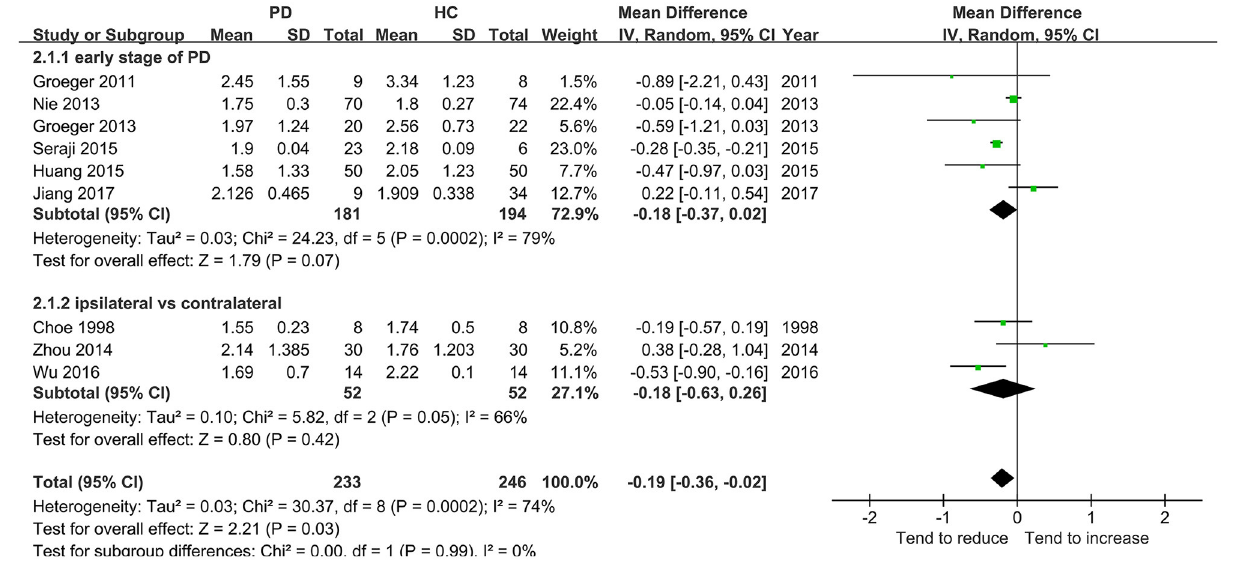
high that the conclusion differed from the finding of a previous study (33) in which no significant changes in the NAA/Cr were observed in the basal ganglia. Although the study (13, 14)